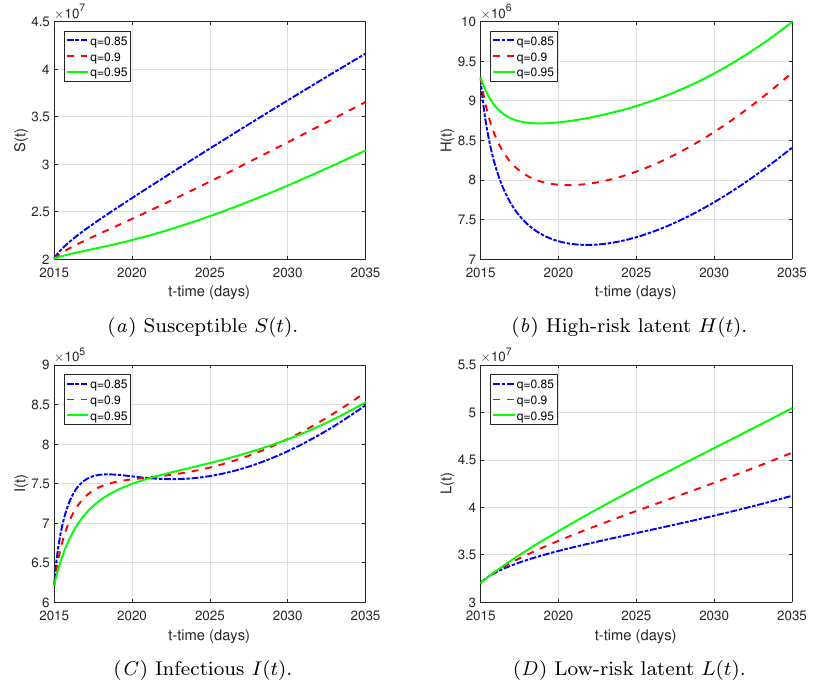
Figure 1. No control: Epidemiological classes. Table 2. Uncontrolled case: Esti- mates for H + I , I and S in